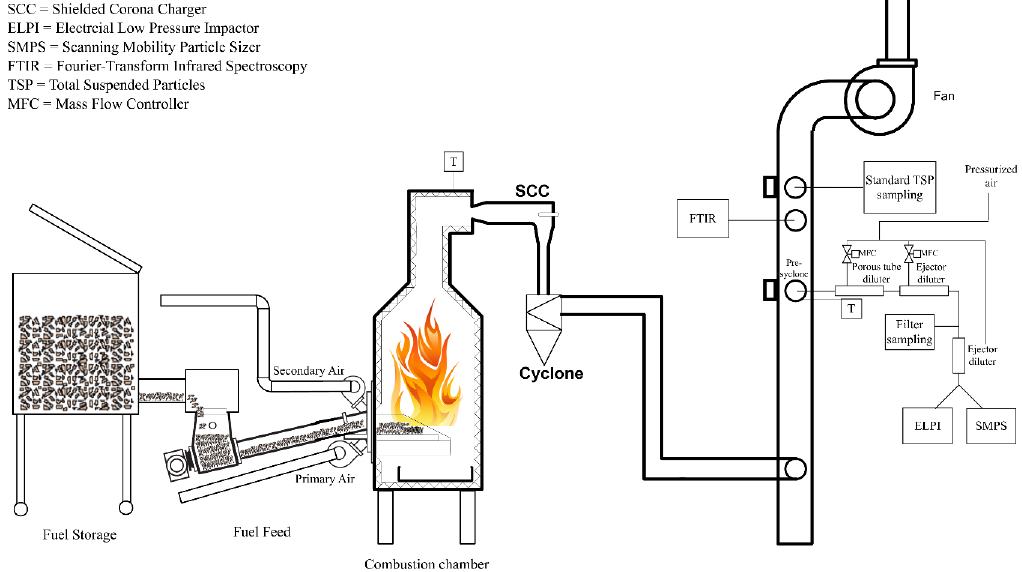
Figure 4. Experimental setup in the shielded corona charger (SCC) –Cyclone measurements.